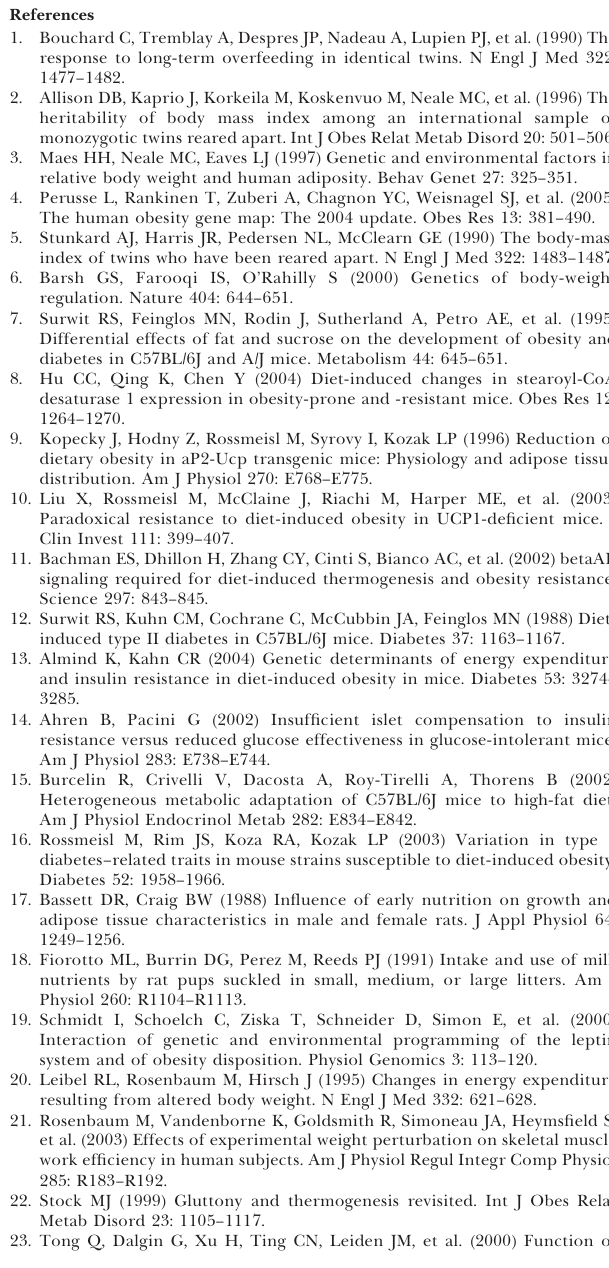
Table S1. Microarray Analysis of the Hypothalamus of High and Low Gainer Mice Found at DOI: 10.1371/journal.pgen.0020081.st001 (131 KB